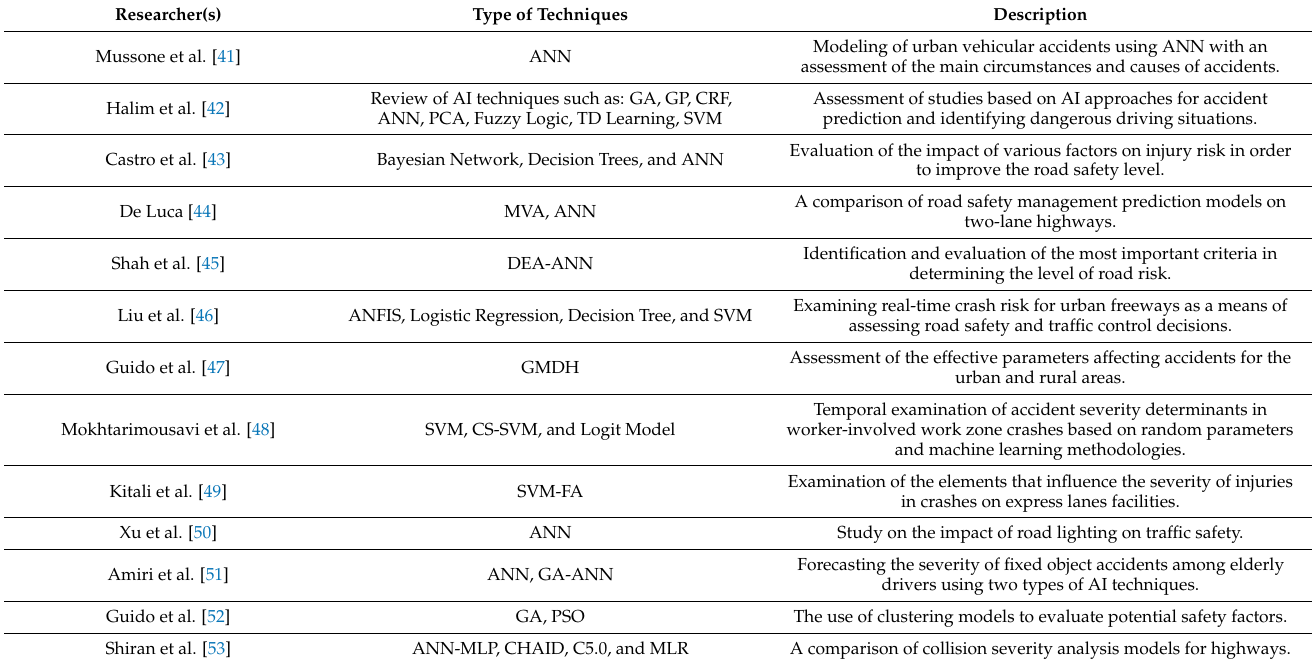
Table 1. A brief overview of some studies that employed machine learning techniques